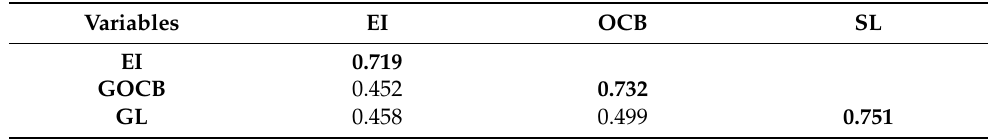
Table 3. Fornell–Larcker Criterion (Discriminant